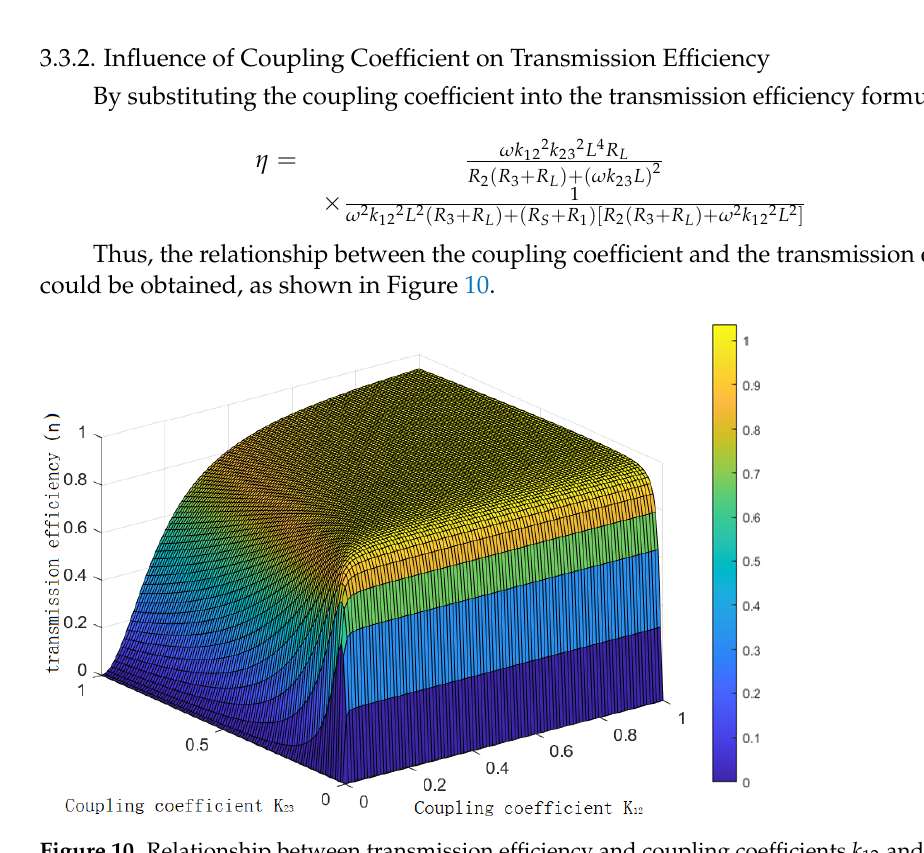
Figure 10. Relationship between transmission efficiency and coupling coefficients k 12 and k 23 .